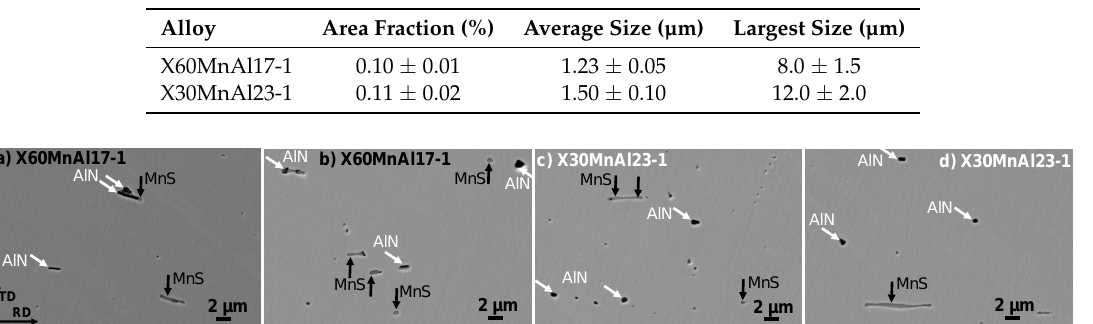
Figure 3. SEM micrographs depicting non-metallic inclusions present in the investigated alloys: X60MnAl17-1 ( a , b ); X30MnAl23-1 ( c , d ); manganese sulphide (MnS) (black arrows) and aluminium nitride (AlN) (white